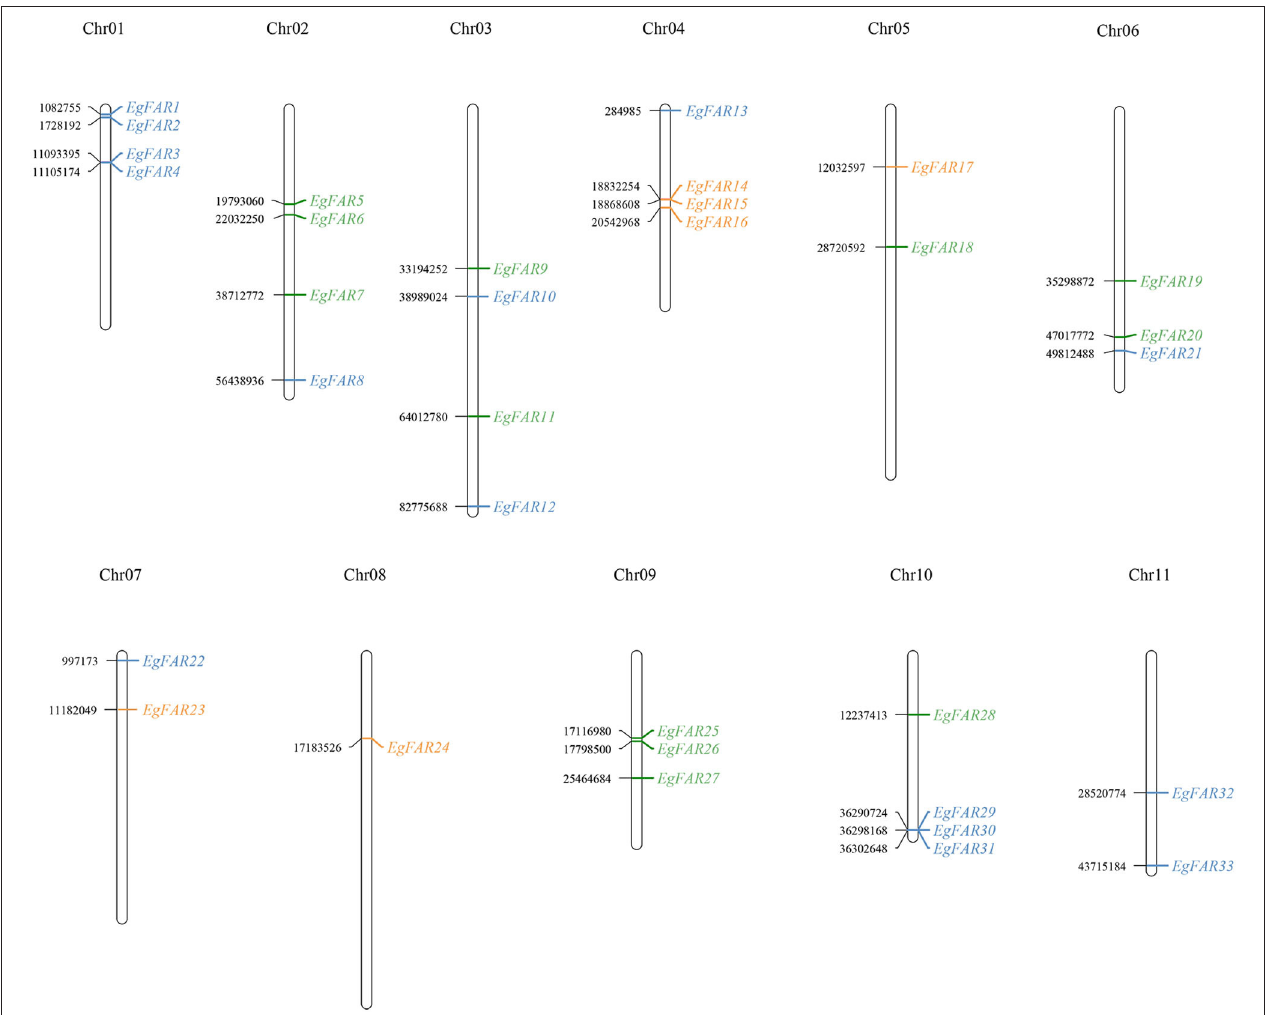
FIGURE 2 | Chromosome locations of FAR1/FHY3 genes on 11 Eucalyptus grandis chromosomes. The number of chromosomes was displayed at the top of each vertical line. The position data were shown on the left side of the chromosome and the gene name on the right side. Blue: FAR1/FHY3 Group I; Orange: FAR1/FHY3 Group II; Green: FAR1/FHY3 Group III; chr: